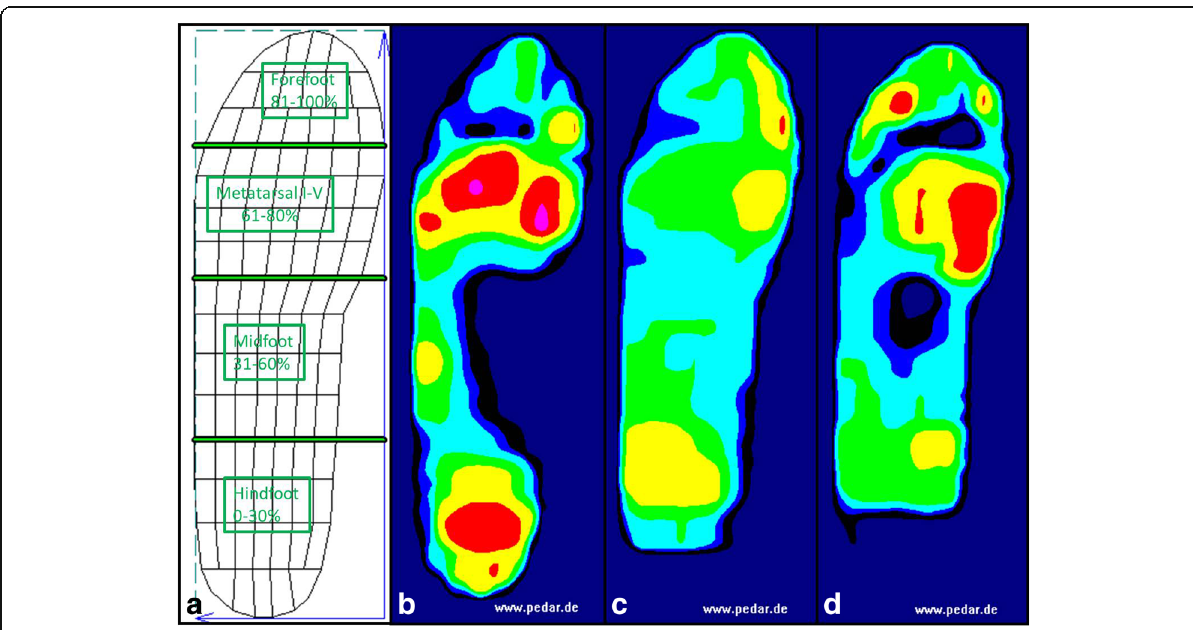
Fig. 1 Demonstrating the subdivision of the plantar surface into four anatomical regions ( a ). Exemplary graphical illustration of mean peak